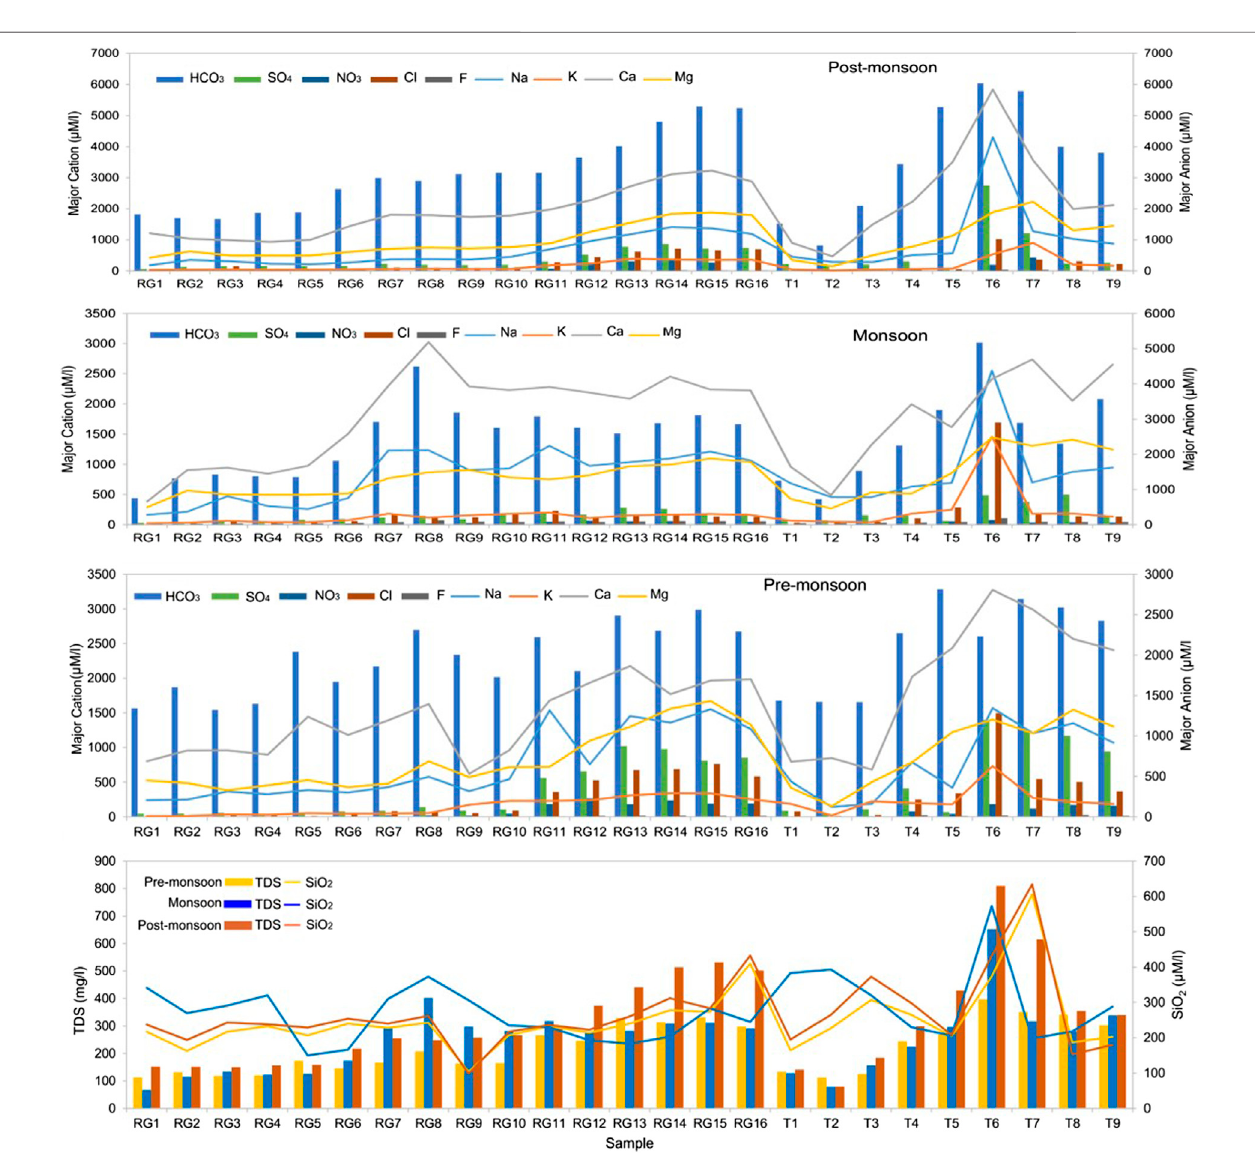
FIGURE 4 | Spatial and temporal variation in total dissolved solids (TDS), SiO 2 , and major ions in the Ramganga River and its tributaries.